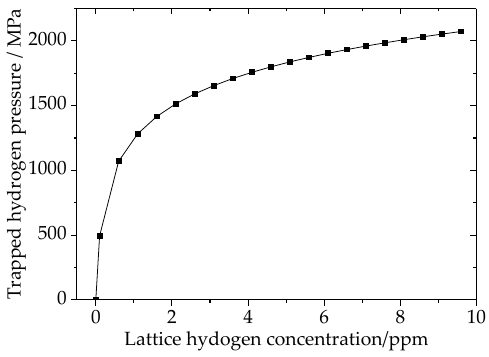
Figure 7. Trap hydrogen pressure variation vs. lattice hydrogen content.